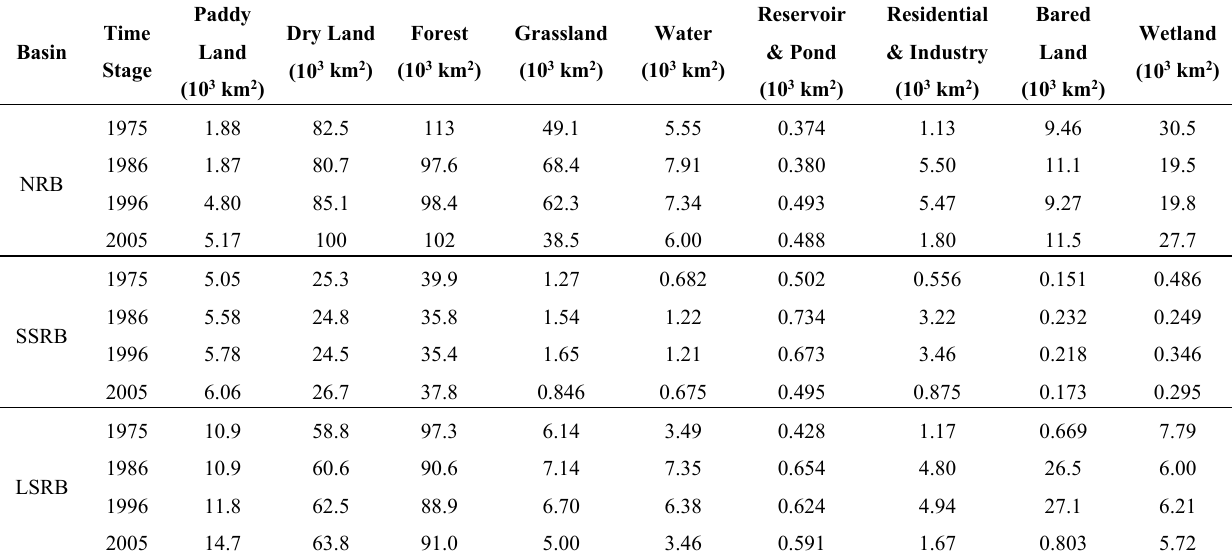
Table 6. Land use in 1975, 1986, 1996 and 2005 in the Nenjiang River Basin (NRB), Second Songhua River Basin (SSRB), and Lower Songhua River Basin (LSRB) in Northeast